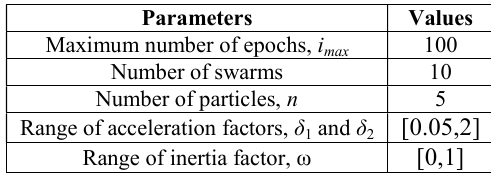
Table 1. Pseudocode of the PSO-FOPID controller